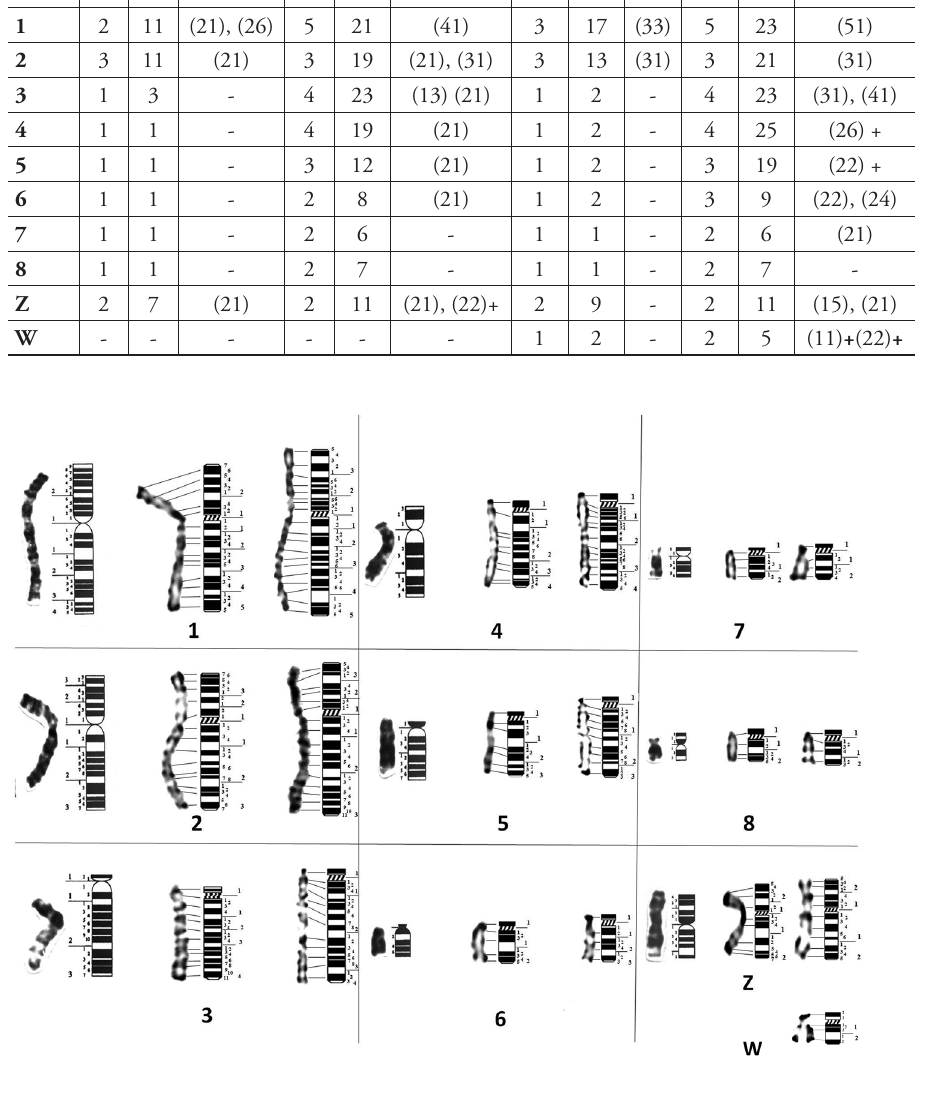
Figure 4. GTG partial ideograms of (from left to right) G. domesticus (Ladjali-Mohammedi et al. 1999), A. barbara and A. chukar. W chromosome is represented only in A.chukar . Horizontal traits indicate cor- respondence of positive bands between chromosomes and ideograms. Along ideograms: Large numbers indicate regions, smallest numbers indicate positive and negative bands.